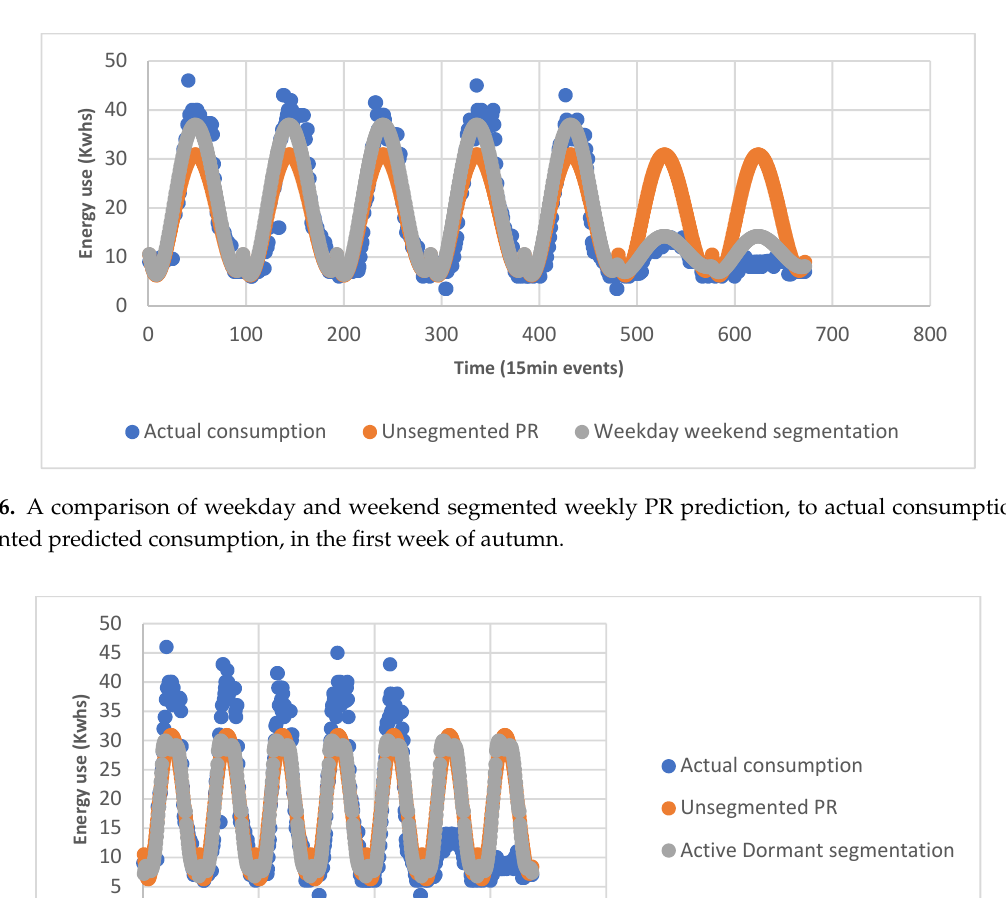
Figure A5. A comparison of the first week of spring’s energy use to the PR predicted energy use.